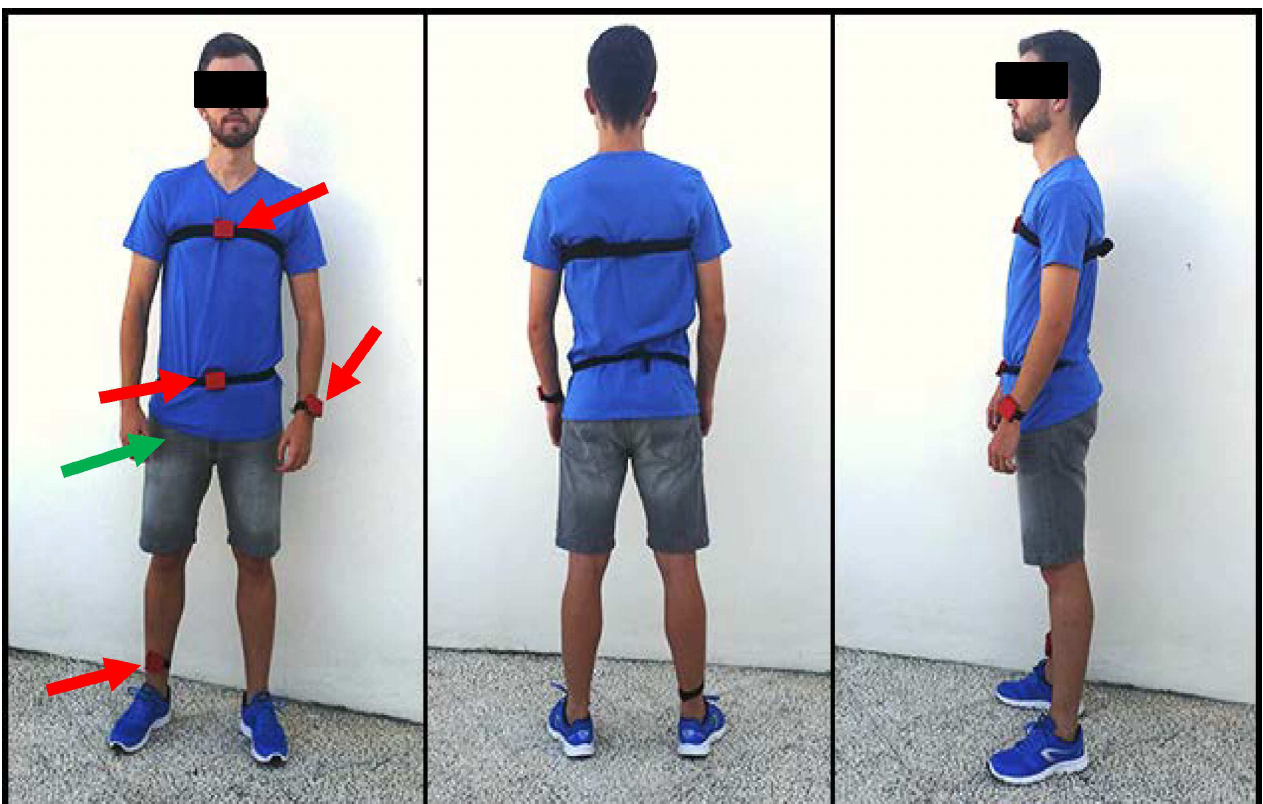
Fig 2. Experimental subject with the multisensory